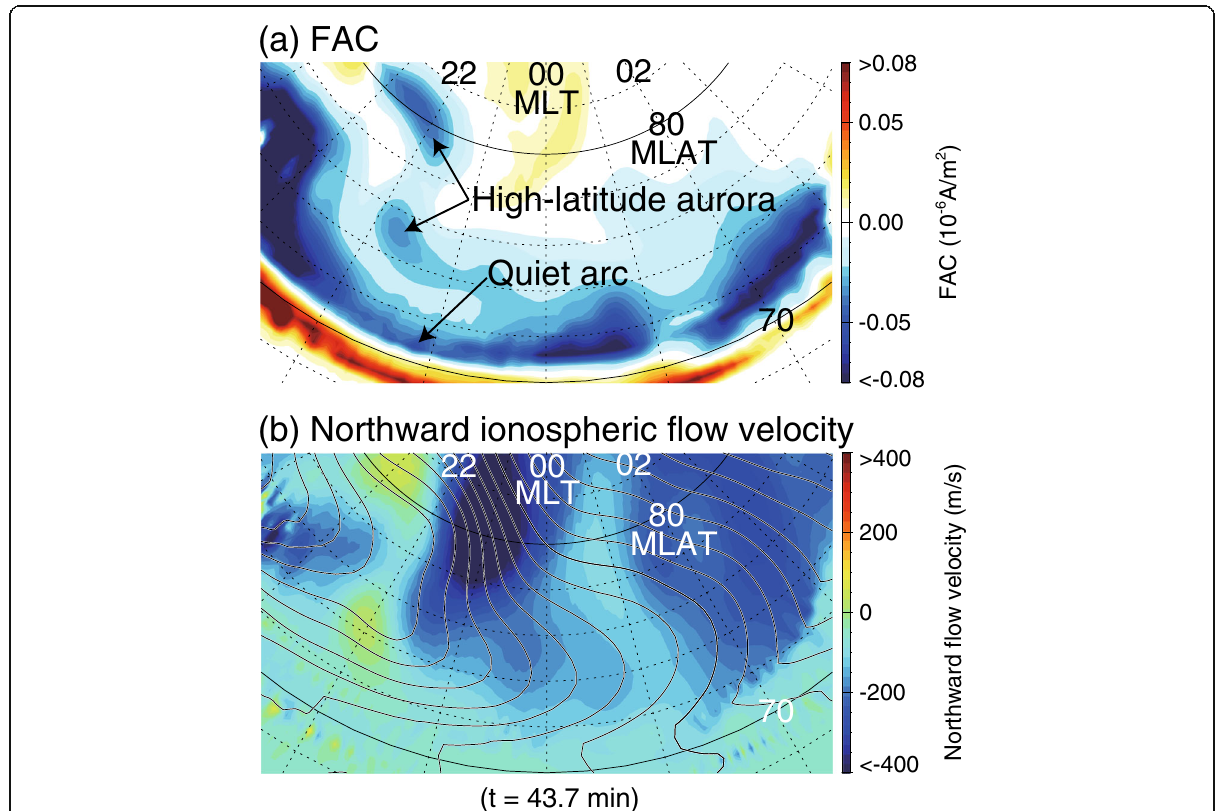
Fig. 6 a Simulated high-latitude aurora and b northward ionospheric flow velocity during the growth phase (at T = 43.7 min). The contour line indicates the ionospheric electric potential at an interval of 2 kV. (Adapted from Ebihara and Tanaka